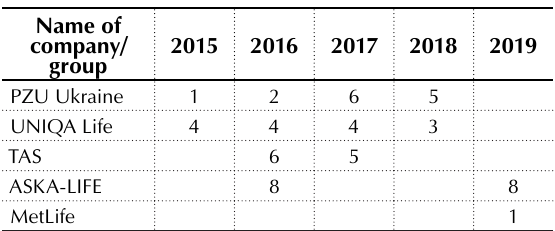
Table 3. Results of National ranking of insurance